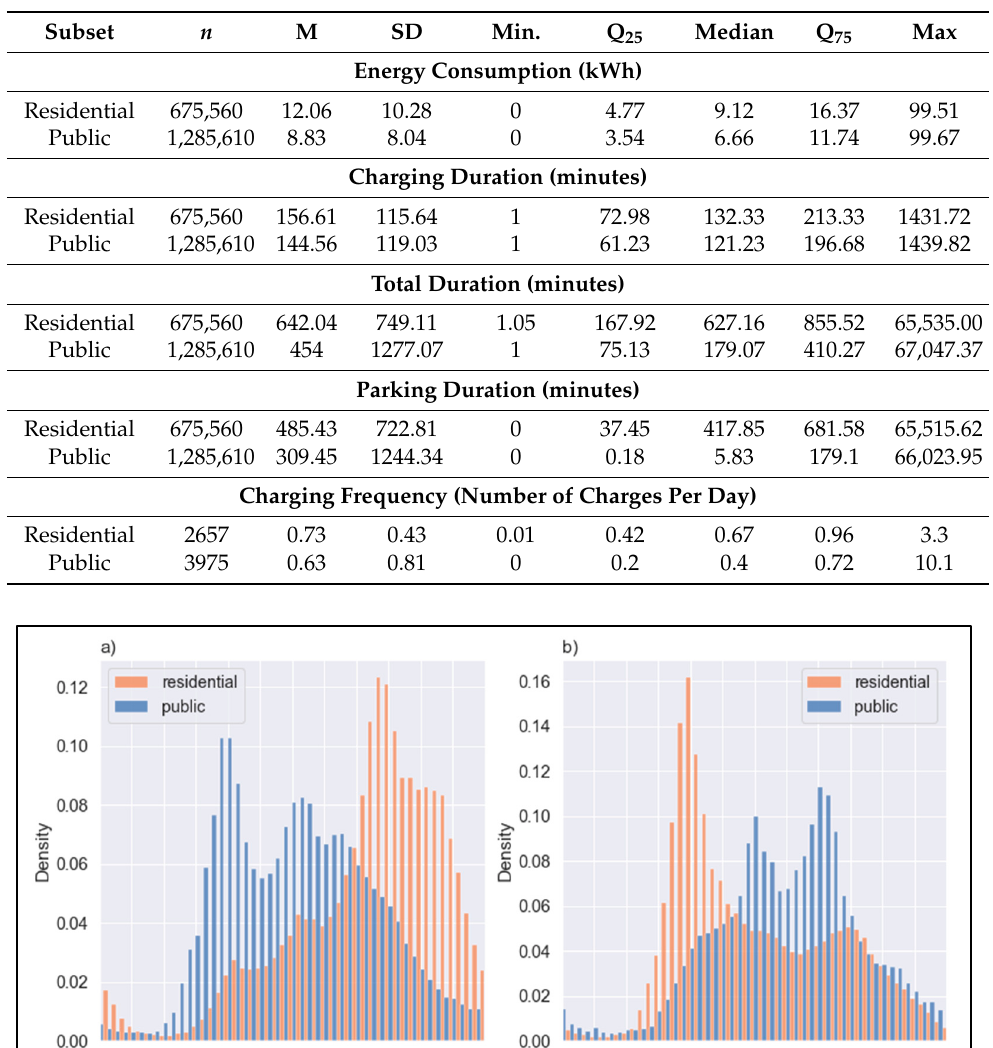
Table 2. Summary statistics of utilization variables for residential and public Level 2 charging sta- tions.